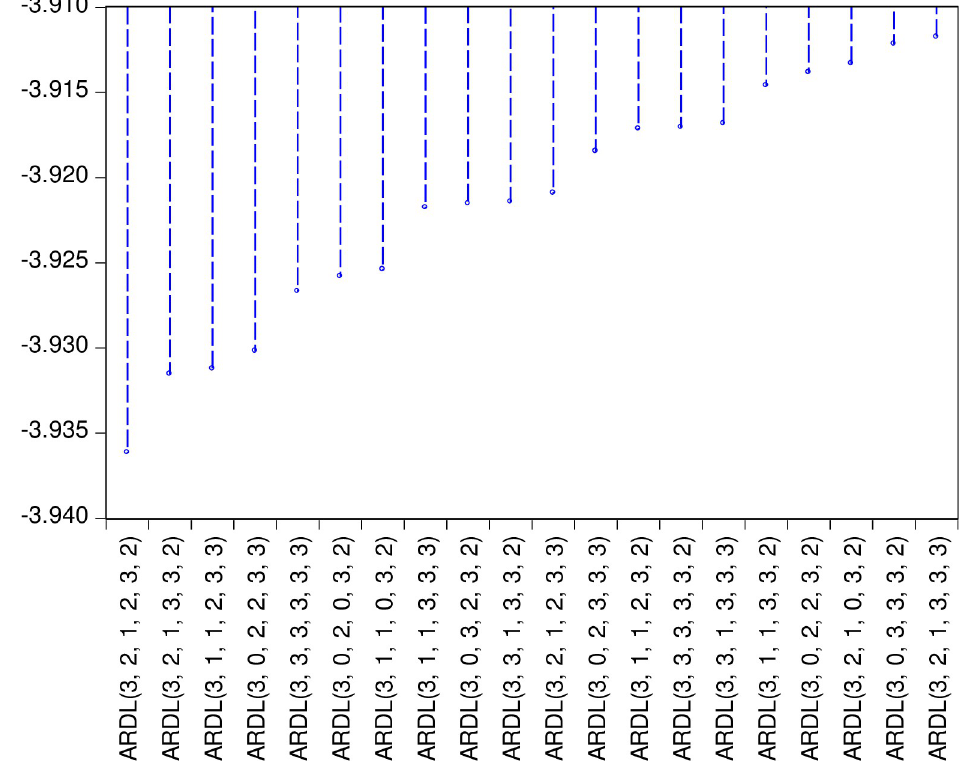
Fig 1. Specification of the 20 best models based on AIC